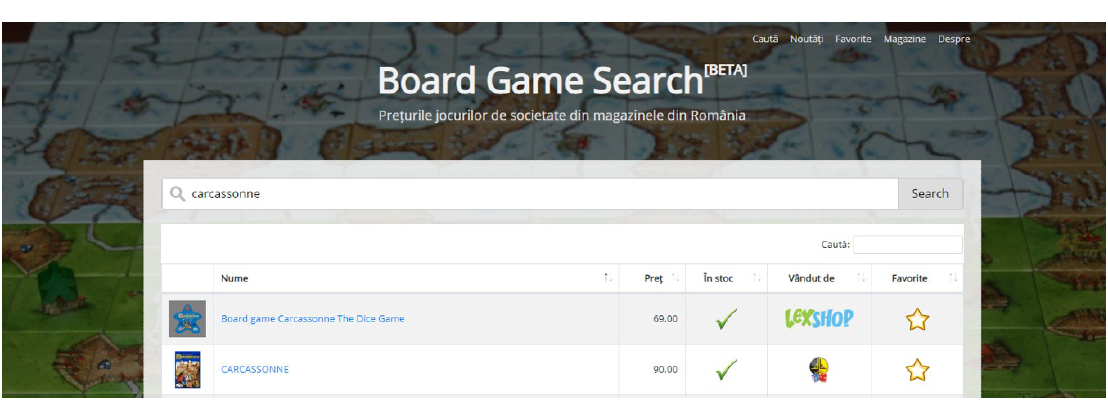
Figure 2. Results page for the board game search website: http://boardgamesearch.h23.ro. 370